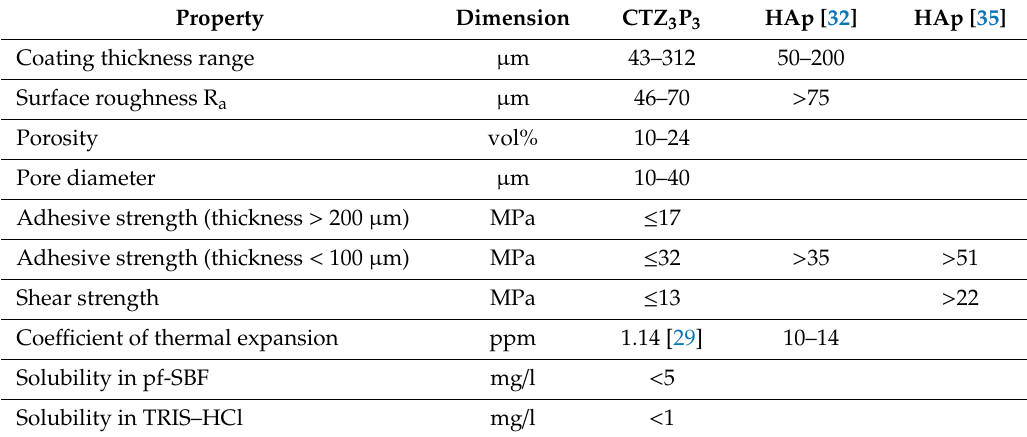
Table 4. Selected properties of plasma-sprayed CTZ 3 P 3 coatings and performance requirements for commercial hydroxylapatite coatings [31,35]. See also